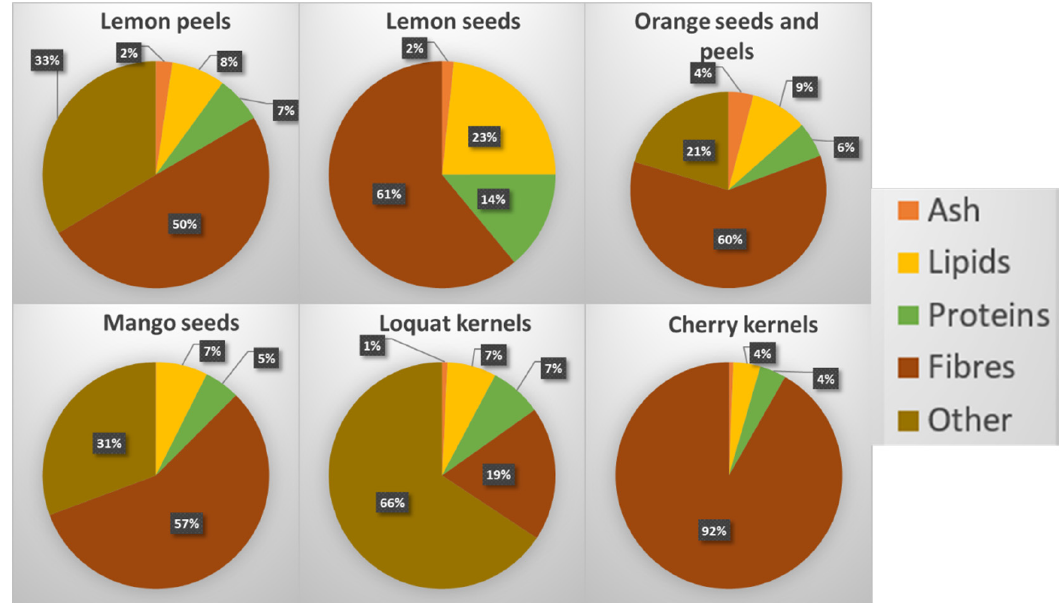
Figure 3. Proximate composition of the residual pellets remained after EAE. Each analysis was performed in duplicate and the results are expressed as their mean and as a percentage on dry matter (%DM). The percentage of “other” was calculated by the difference from 100.